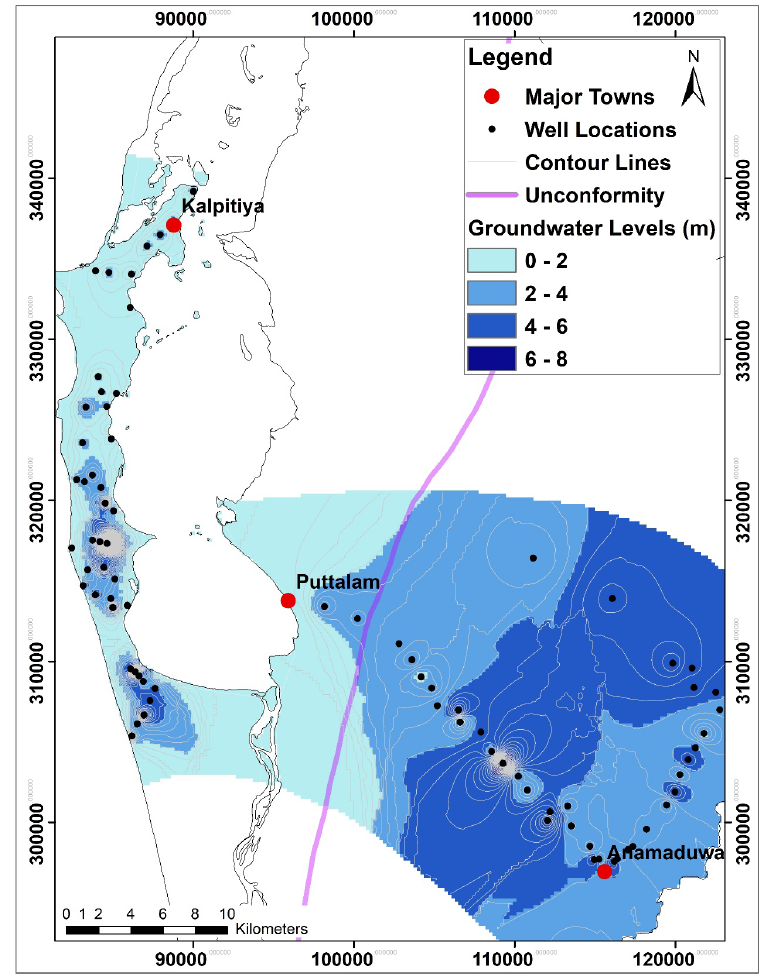
Figure 6: Kriged distribution of depth to groundwater level variations in the study